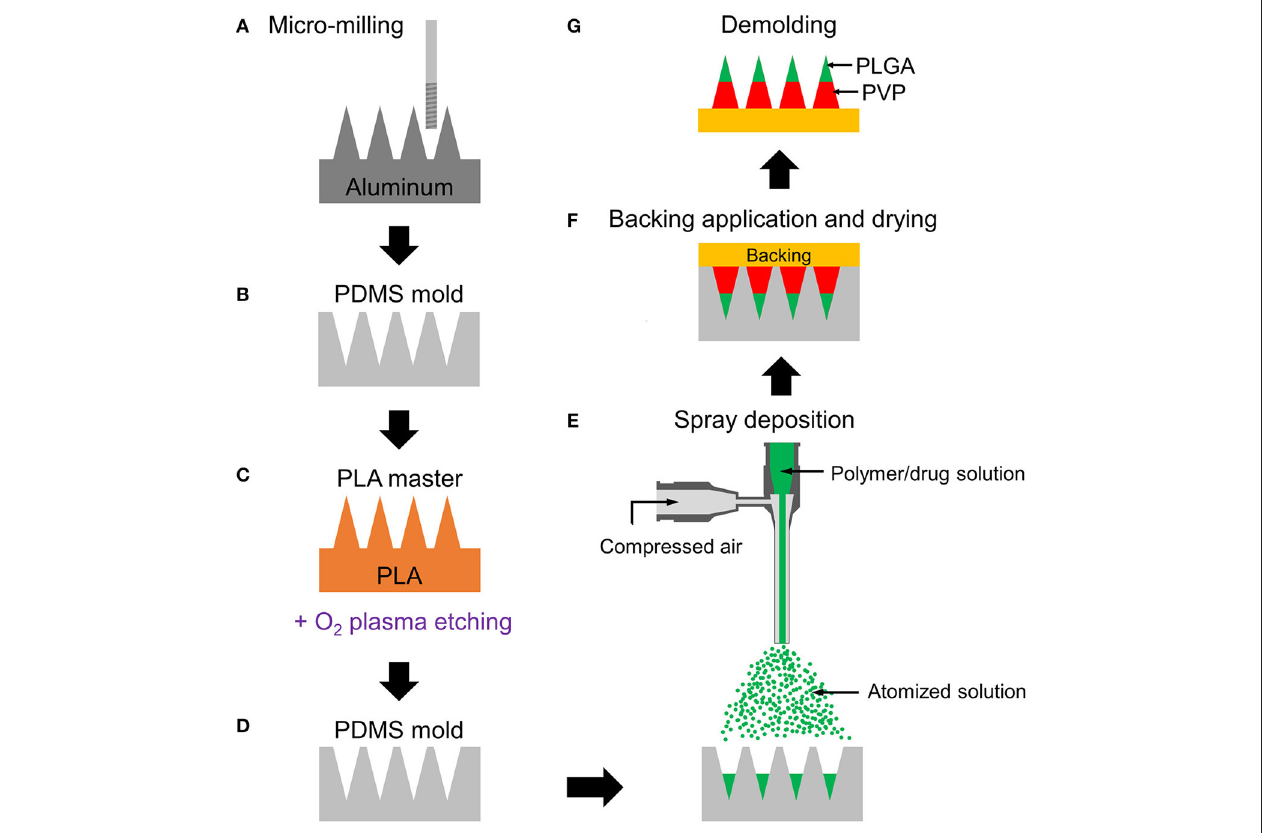
FIGURE 1 | Schematic fabrication process of multilayer microneedles. (A) Aluminum master fabrication using micro-milling. (B) Replication of PDMS mold from the master. (C) Fabrication of PLA master by micromolding and tip-sharpening using oxygen plasma. (D) Replication of PDMS mold from the PLA master. (E) Spray deposition of drug-containing polymer solution to fill the mold cavity. Multilayer microneedle is formed by sequential deposition of polymer solutions. (F) Application of backing material (yellow) on the mold and drying at room temperature for polymer solidification. (G) Demolding solidified multilayer microneedle array from the mold. Green and red represent PLGA and PVP layers,